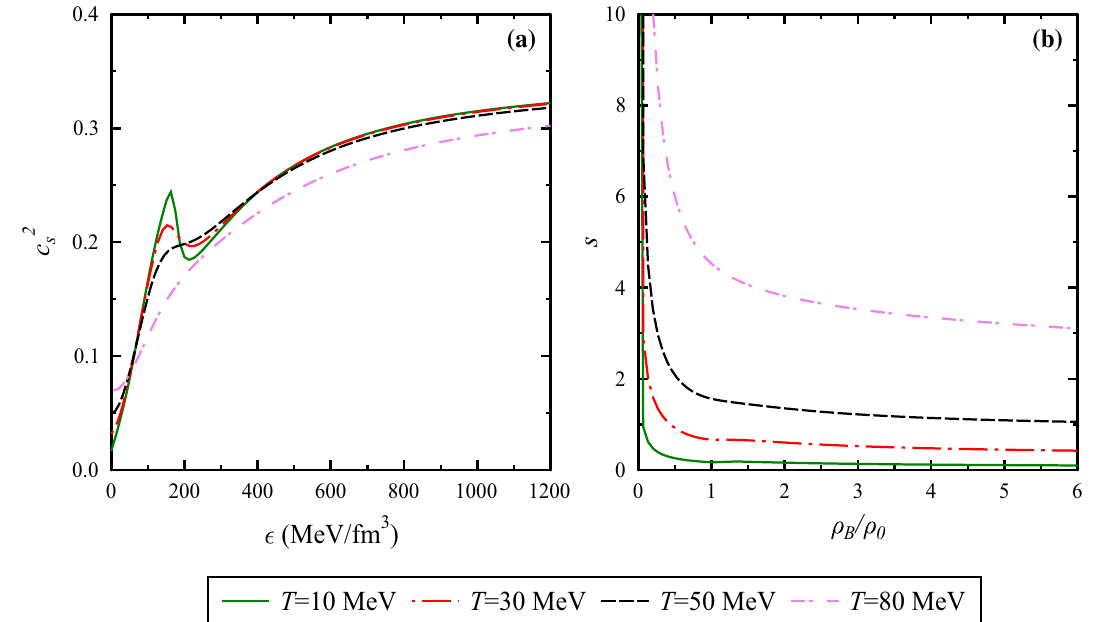
Fig. 3 a The sound velocity square, c 2 s , as a function of energy density (cid:24) , b the entropy per baryon, s , as a function of baryonic density for strange quark matter at T = 10, 30, 50 and 80 MeV